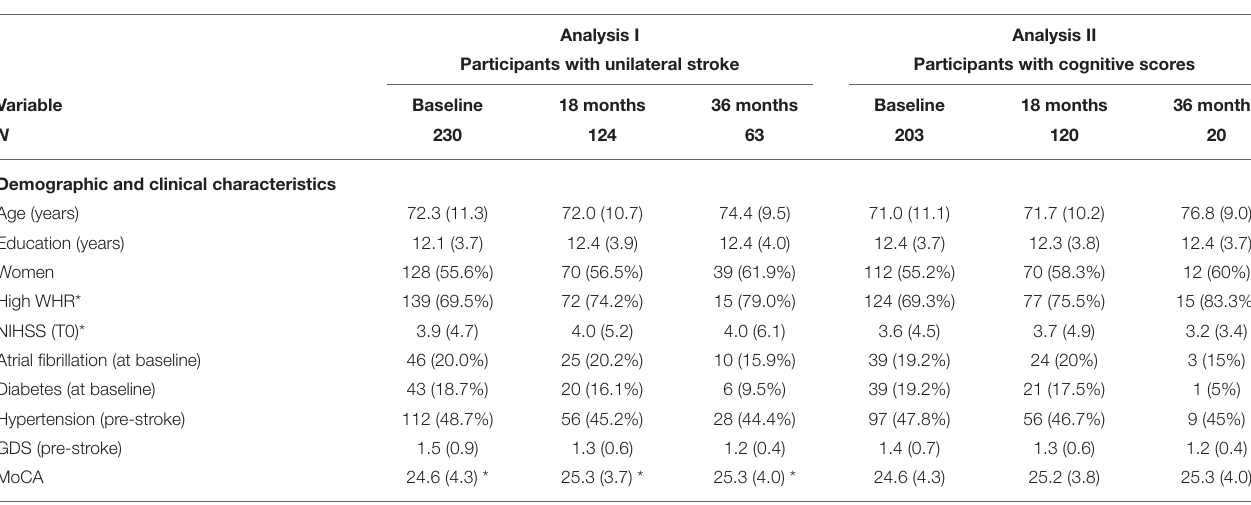
TABLE 1 | Participant characteristics, mean (SD) or n